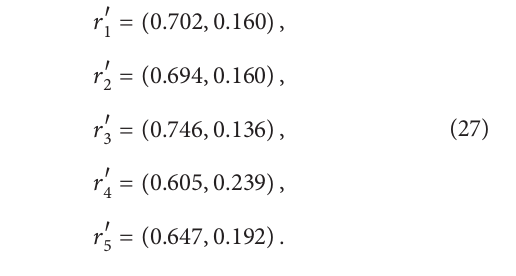
Table 3: Intuitionistic fuzzy decision matrix 𝑅 (2) .